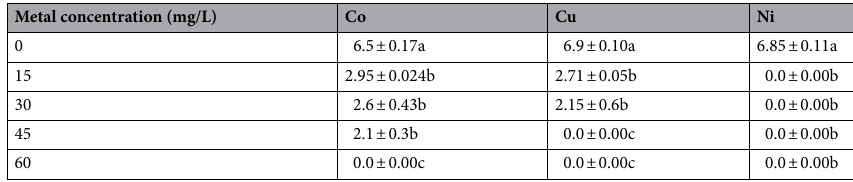
Table 1. Comparison of the mean colony diameter of Pleurotus sp . (cm) grown in MMN solid culture medium containing heavy metals based on Duncan’s test. Treatments with the same letters are not statistically different.